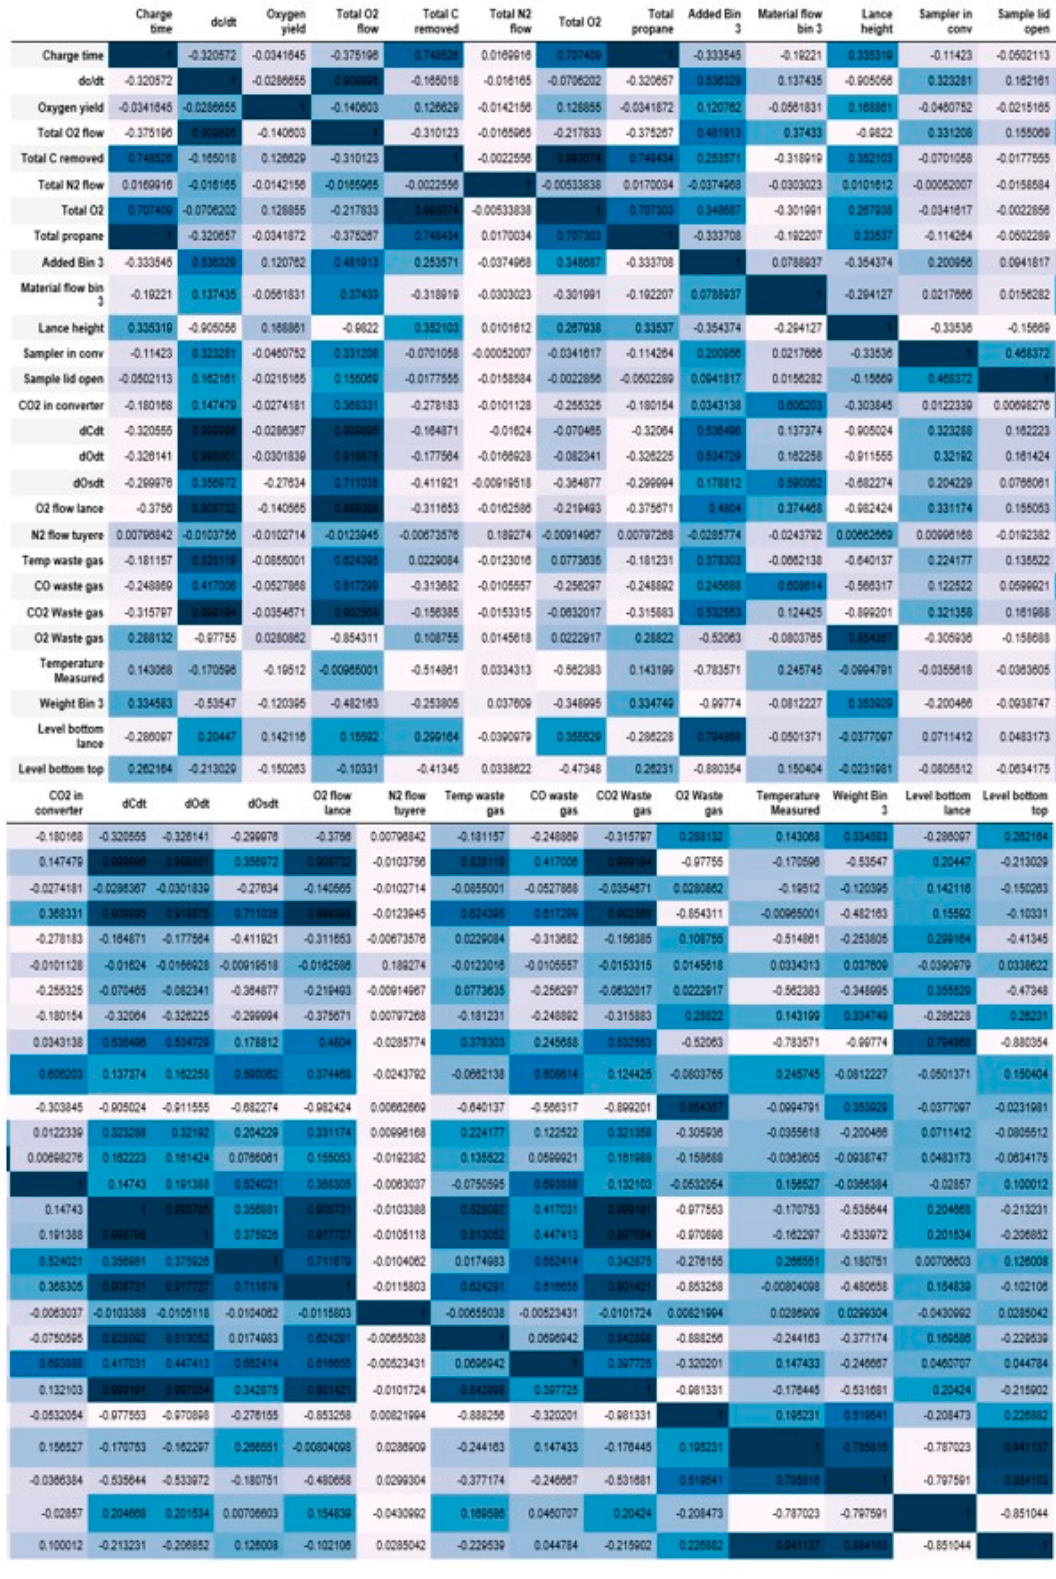
Figure 2. The correlations between different features within the dataset from the six-ton (6t) pilot plant trial. The figure has been vertically split into two parts, and the top and the bottom shown above are actually the left and right parts of the figure, respectively.